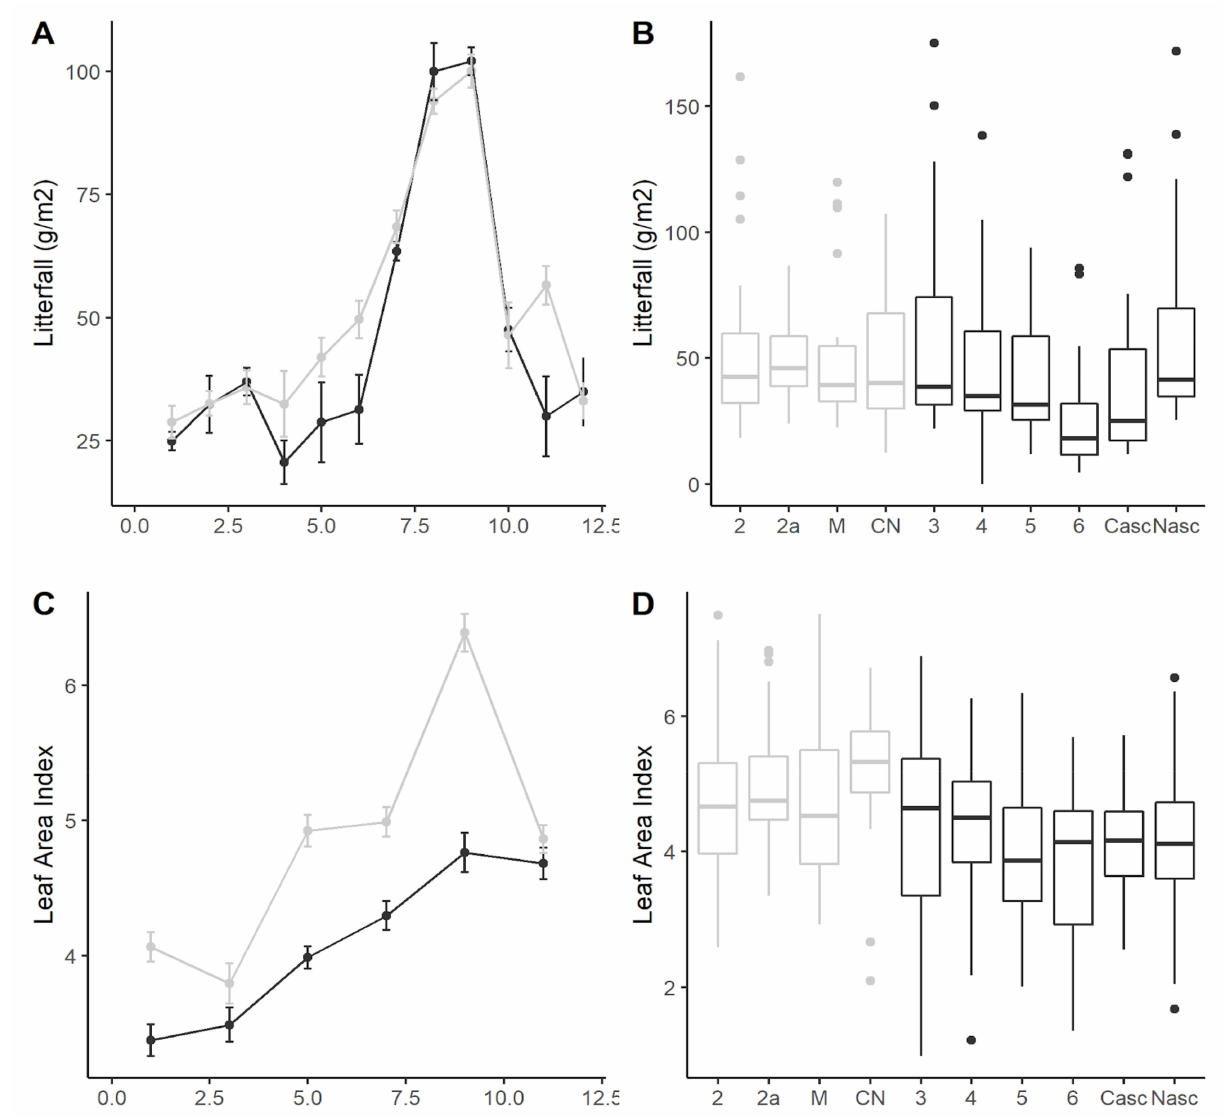
Figure 3. Spatial and temporal patterns in litterfall and LAI. ( A ) Intra-annual variation in litterfall biomass (g/m 2 /month; mean ± SE), ( B ) Variation in monthly average litterfall across streams, ( C ) Seasonal variation in LAI (monthly mean ± SE), and ( D ) and variation in monthly average LAI across streams. Format of boxplots is as follows: horizontal line indicates the median value, box shows the inter-quartile range, and whiskers extend to 1.5 times the inter-quartile range. Forest streams ( n = 4) are in grey and cropland ( n = 6) streams in black in all